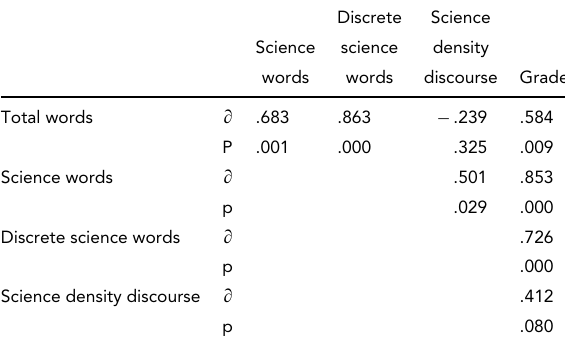
Spearman Rank Order Correlation Coefficients ( (cid:2) ) and Probabilities